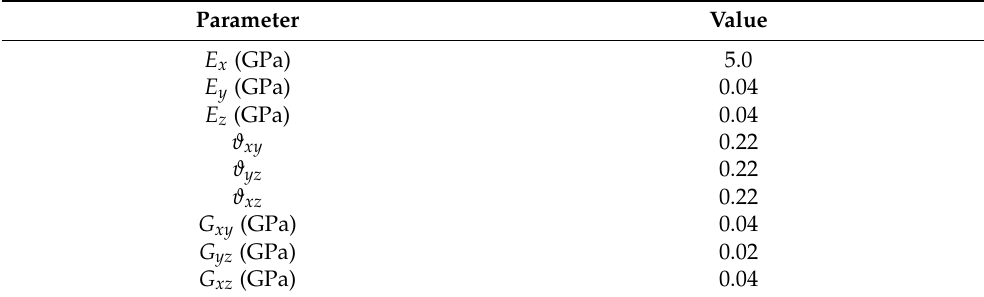
Table 10. Material parameter set for the anisotropic fiber material. Parameter